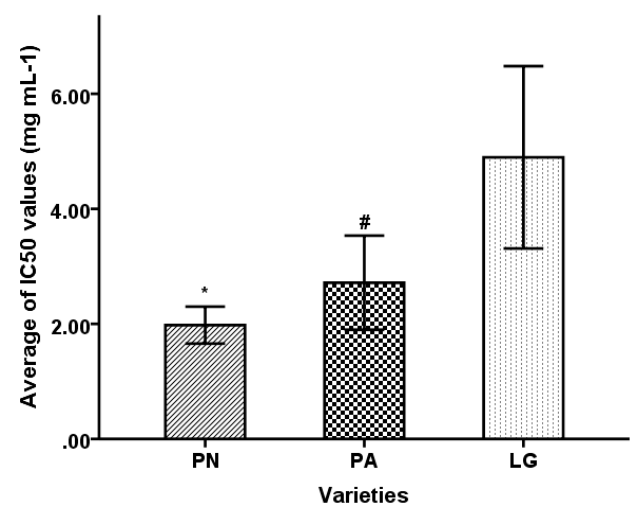
Figure 3. One-way analysis of variance (ANOVA) result of 2,2-diphenyl-1-pyridinohydrazinyl (DPPH) scavenging activity of bamboo leaves from PN, PA, and LG. * means the activity of LG was significantly di ff erent from that of PN ( p < 0.05). # means the activity of LG was significantly di ff erent from that of PA ( p < 0.05).